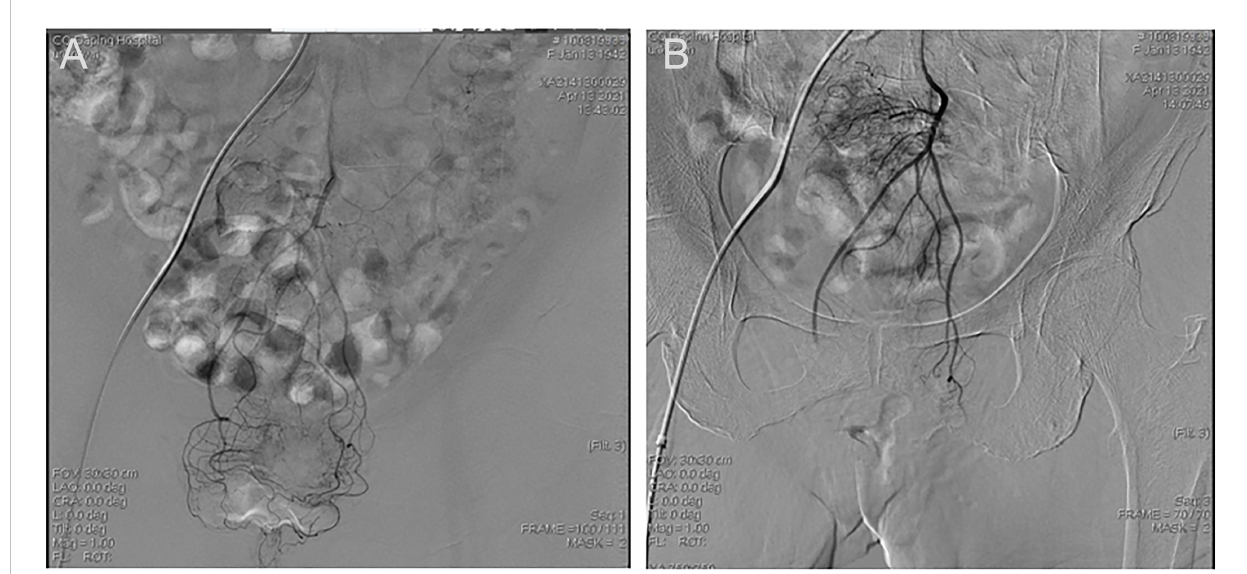
FIGURE 2 Representative images of a LARC patient undergoing TRACE. (A) Frontal inferior mesenteric artery iodixanol angiography. (B) Frontal superior rectal arteriogram after